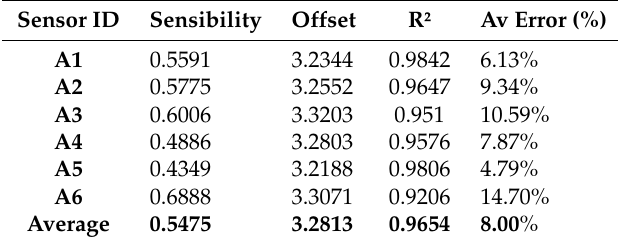
Table 1. Pressure sensor static characterization